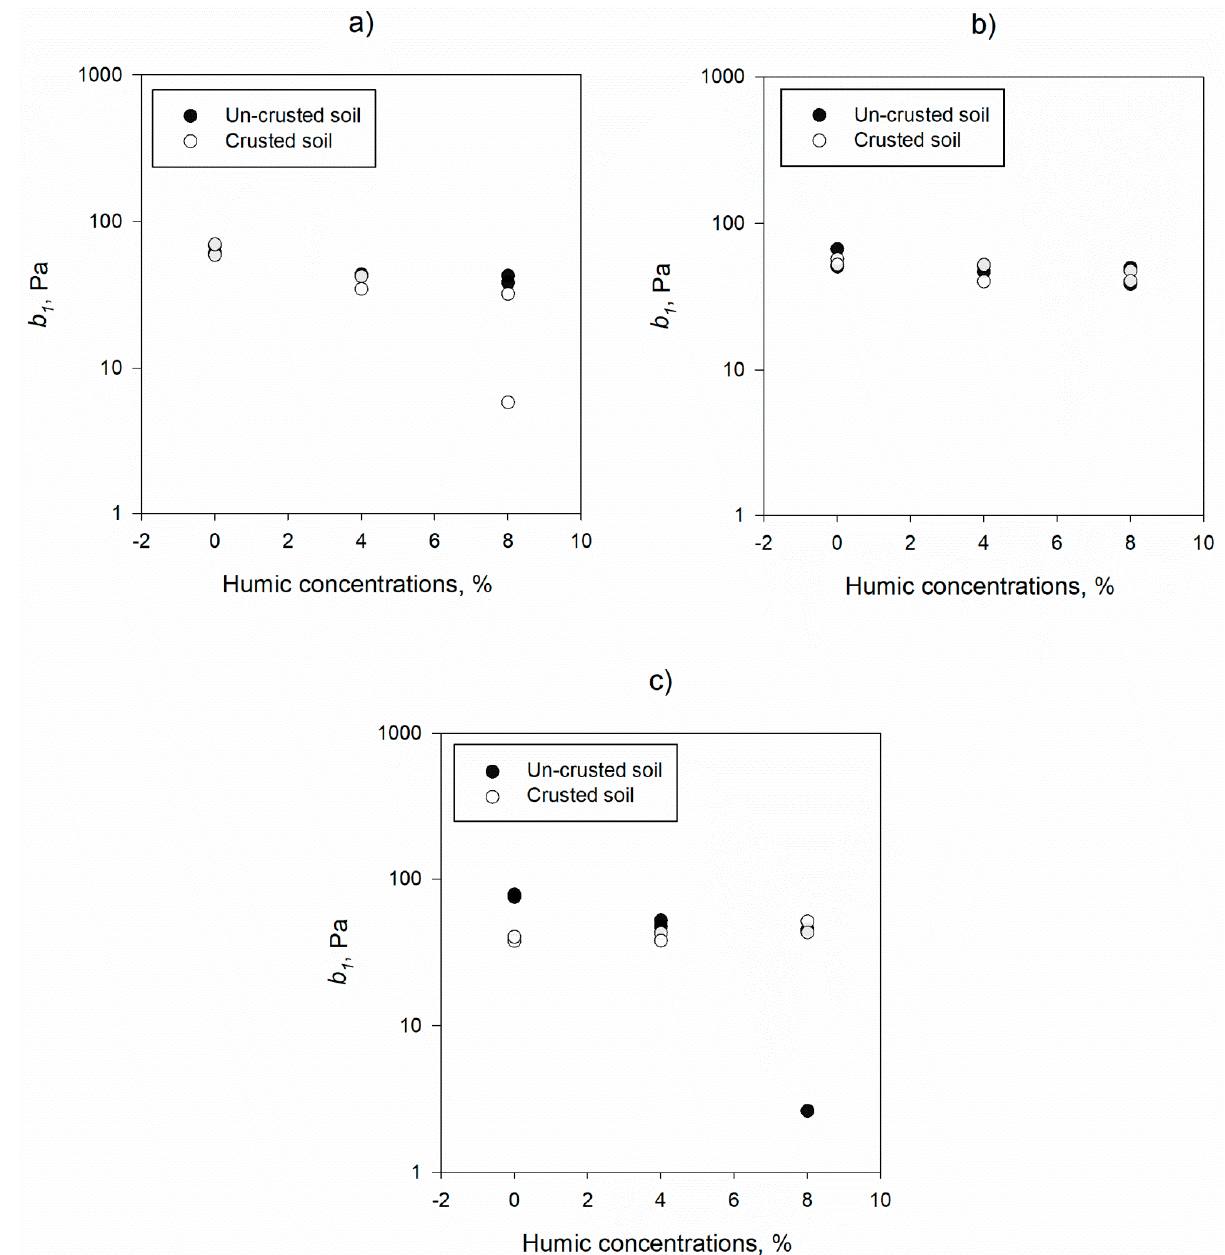
Figure 6. The influence of humic acid concentrations of 0%, 4%, and 8% on the dimensional soil threshold parameter ( b 1 ) of the Wilson model derived from the JET instrument achieved on soil specimens of crusted and uncrusted soils for curing times of: ( a ) one week, ( b ) two weeks, and ( c ) three weeks. Note that each test was replicated.